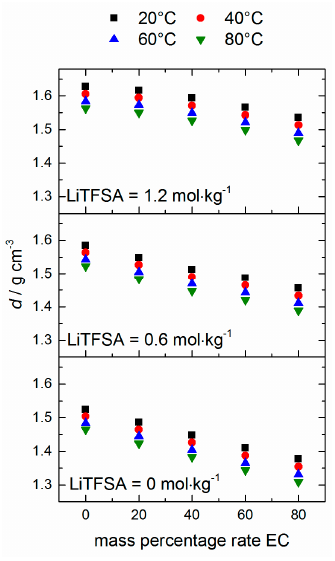
Figure 3. Density values of selected mixtures at T = (20–80) °C.